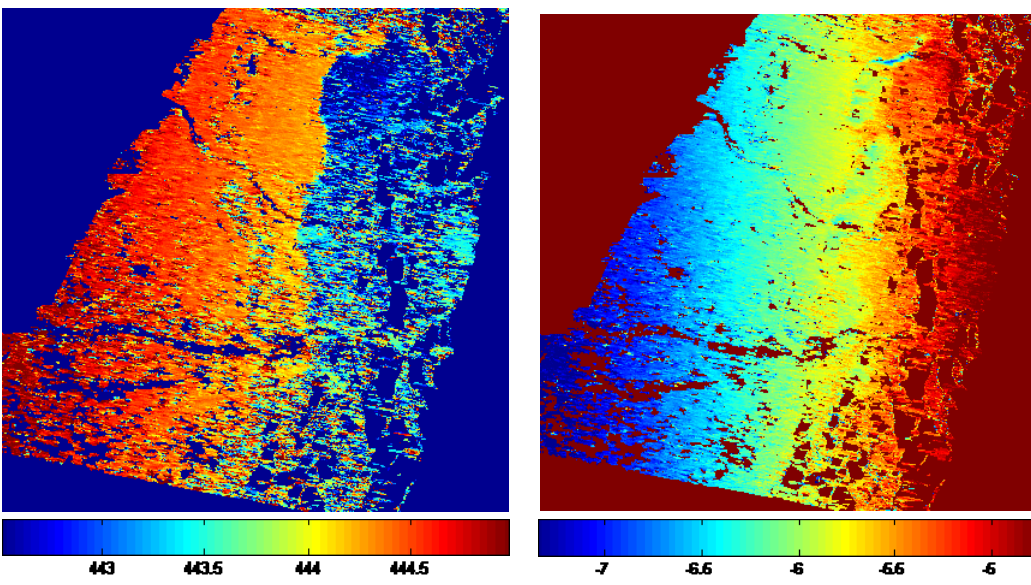
Figure 3. The estimated of AZO (left) and RO (right). Unit: